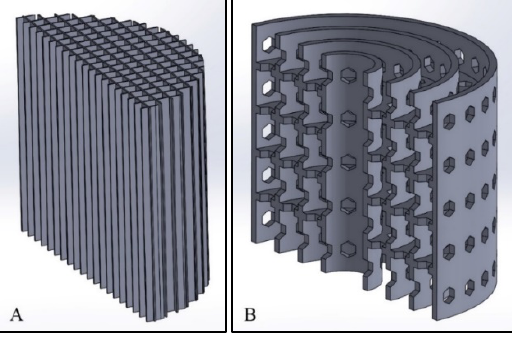
Figure 11. Section view of: ( A ) Rectangular, and ( B ) Honeycomb scaffolds.